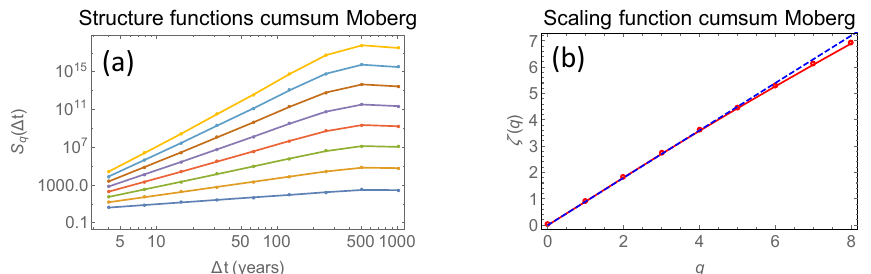
Figure 7. (a) Structure functions for the cumulative sum of the Moberg NH reconstruction year 0–1979. (b) Scaling functions for the cumulative sum computed from straight line fits to the SFs in the scale range 1–500 years.